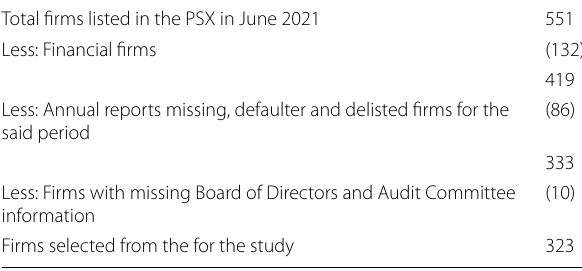
Table 1 Procedures of sample